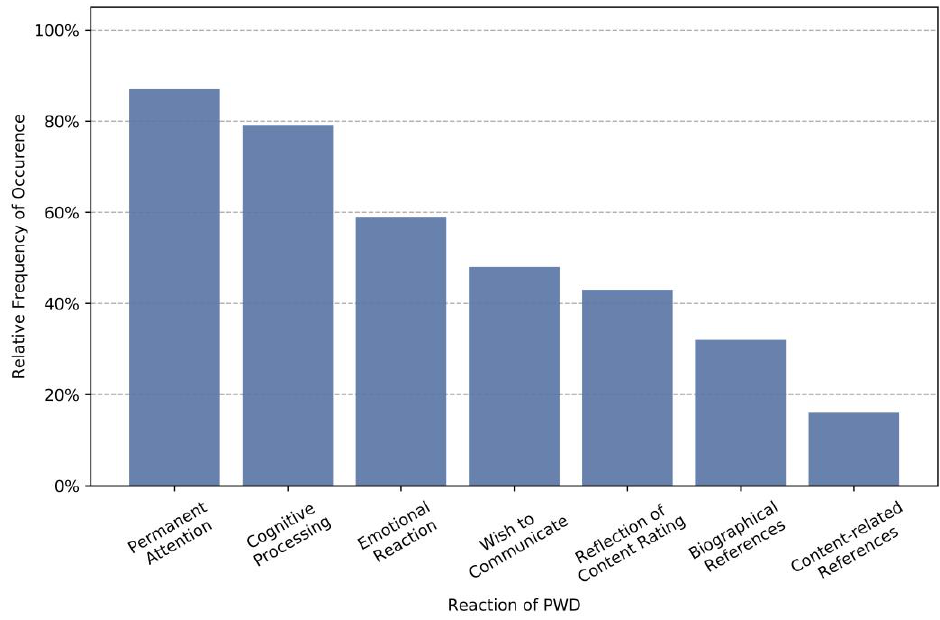
Figure 8. Relative frequency of observed responses to activation material.